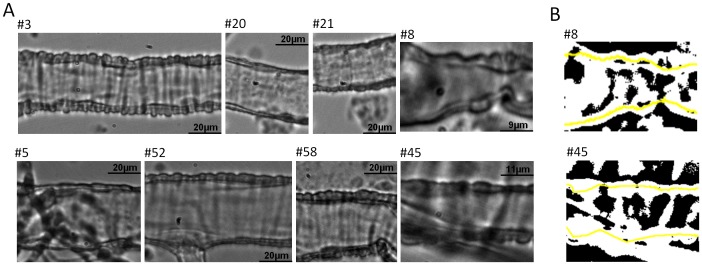
Examples of images taken from the dataset used for analysis.A. Images of 8 retinal arterioles illustrating the diversity we can expect from these kinds of images. B. Binary images made from panels #8 (top) and #45 (bottom) shown on A. The lines estimated by the algorithm are superimposed on these in yellow.